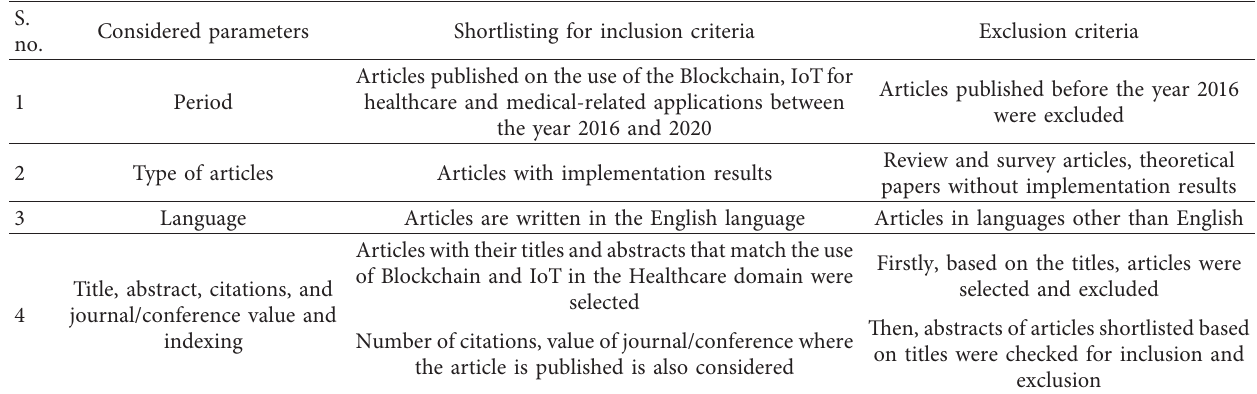
Table 3: Parameters considered for shortlisting and exclusion of